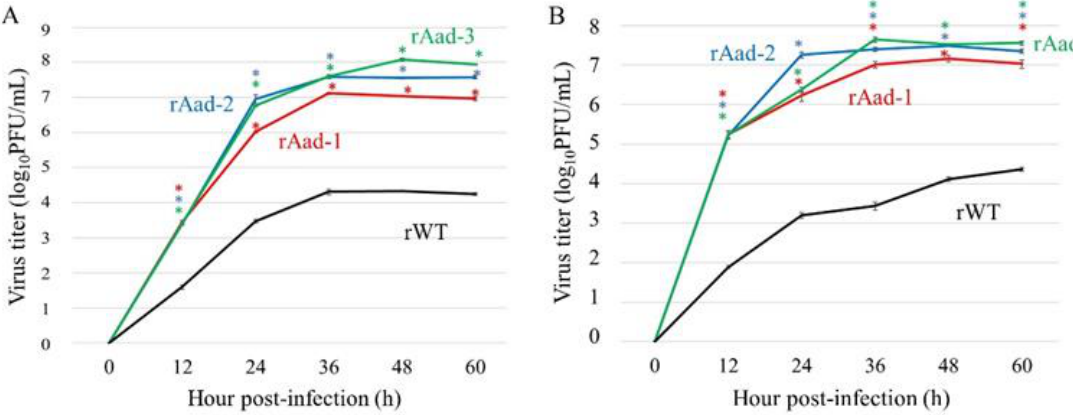
Figure 3. Growth kinetics of A549-adapted viruses in A549 cells at different temperatures. The cells were infected with recombinant A549-adapted viruses (rAad-1, rAad-2, and rAad-3) or recombinant wild-type (rWT) at a multiplicity of infection of 0.01 and incubated at 37 °C ( A ) and 33 °C ( B ). Supernatants were harvested at the indicated time points. Virus titers were determined using plaque assays in MDCK cells. Data present the means ± SD of the result of three independent experiments. * p < 0.05, compared with that of rWT using Dunnett’s test.